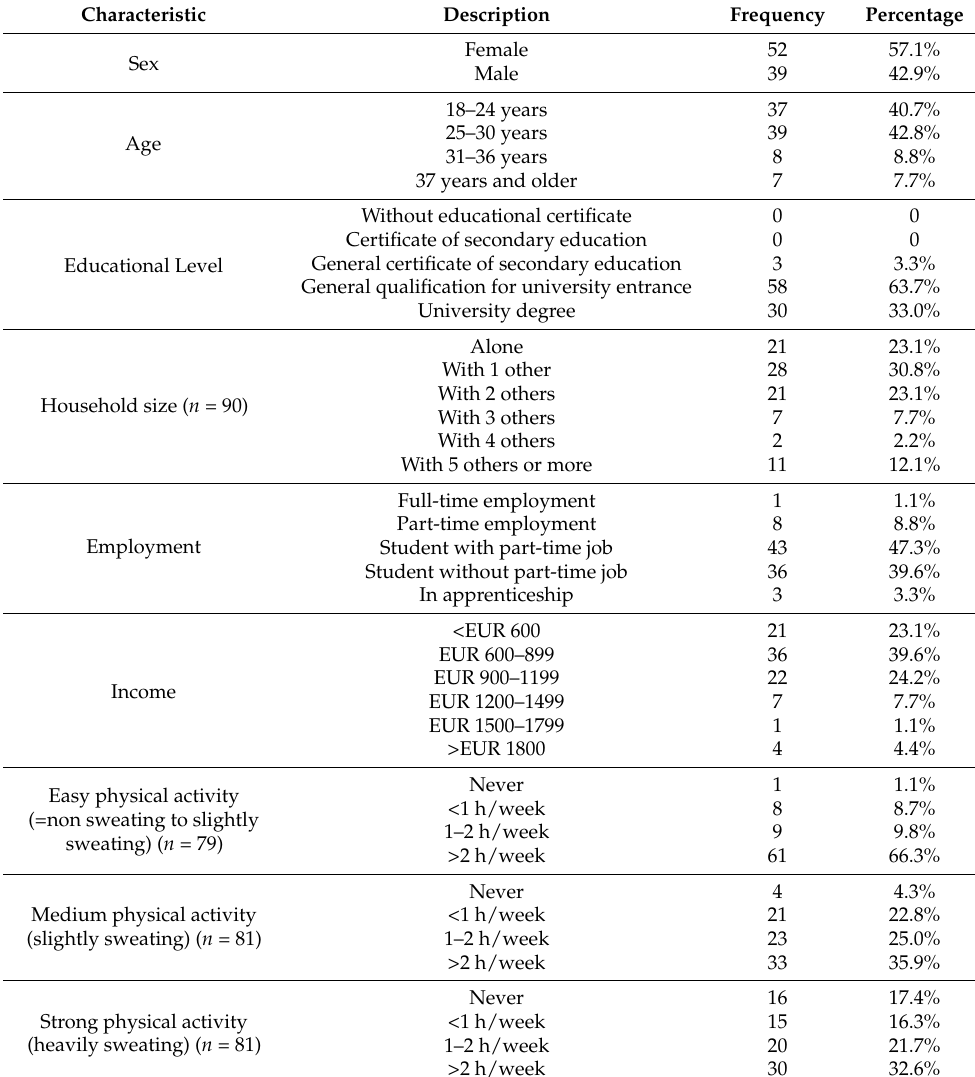
Table 2. Sociodemographic characteristics of the sample ( N =